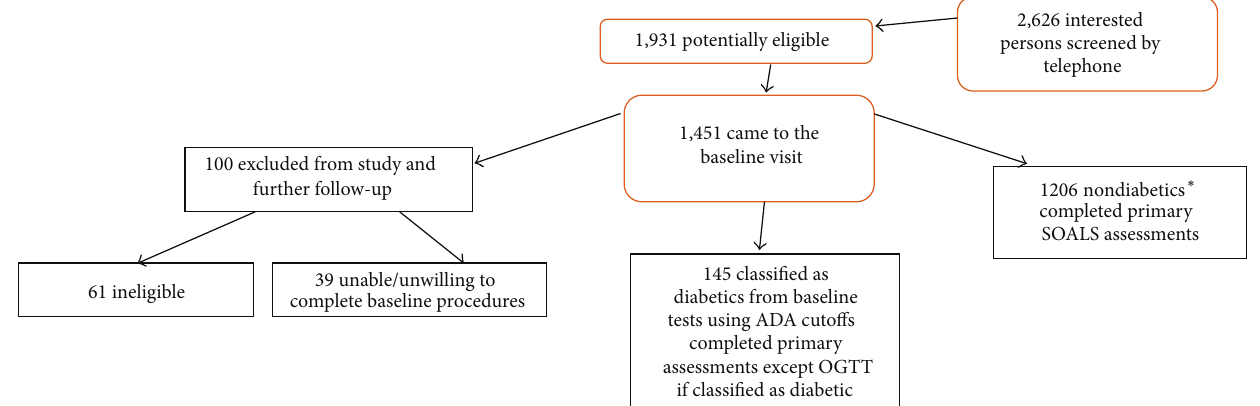
Figure 1: Description of SOALS screening and